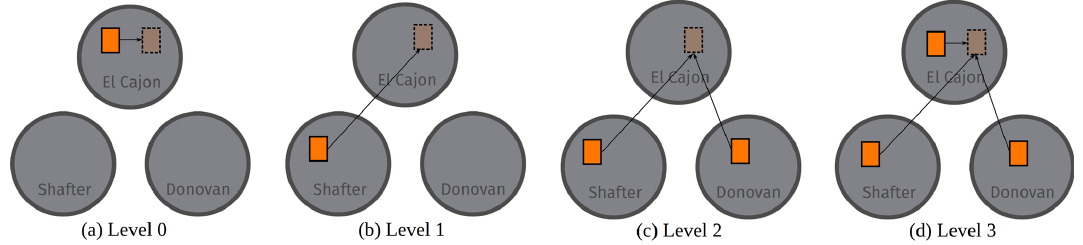
Figure 5. Graphical depiction of training versus testing for the Level 0 through Level 3 benchmarks. The Level 0 and 3 benchmarks test on a training site using held out data. The Level 1 and 2 benchmarks train and test on different sites, also using held out data for